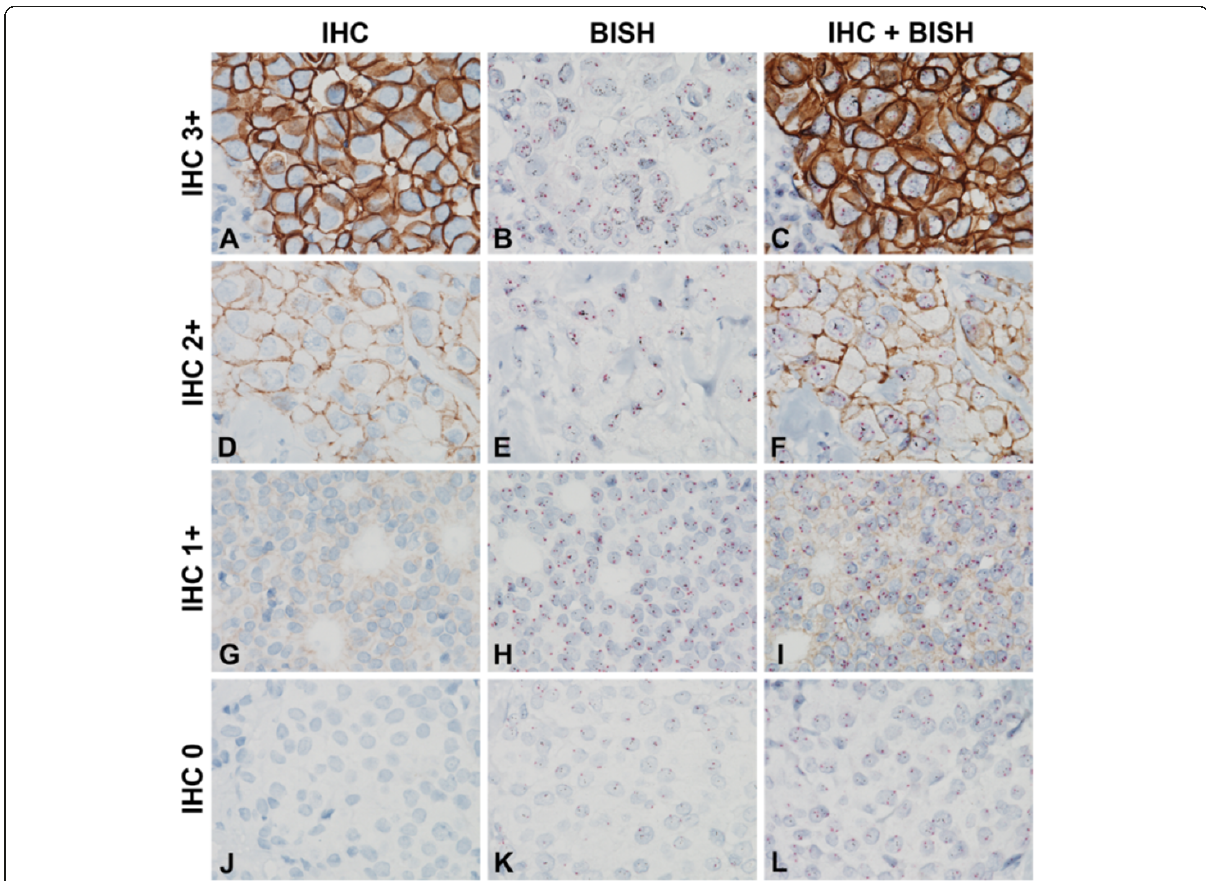
Figure 3 The HER2 gene-protein assay yields appropriate staining of HER2 protein, the HER2 gene, and CEN17 in FFPE clinical breast cancer tissues. Tissues with HER2 IHC scores of 3+ ( A – C ), 2+ ( D – F ), 1+ ( G – I ), and 0 ( J – L ) were subjected to HER2 IHC assay ( A , D , G , J ), HER2 & CEN17 BISH assay ( B , E , H , K ), or the HER2 gene-protein assay ( C , F , I , L ) using tissue microarray slides. HER2 IHC assay yielded the expected HER2 protein staining ( A , D , G , J ) and the separate HER2 & CEN17 BISH assay yielded the expected staining of the HER2 gene (black dots) and CEN17 (red dots) ( B , E , H , K ). The combined assay yielded both the appropriate HER2 protein staining and the appropriate HER2 gene and CEN17 staining ( C , F , I , L ). [All images